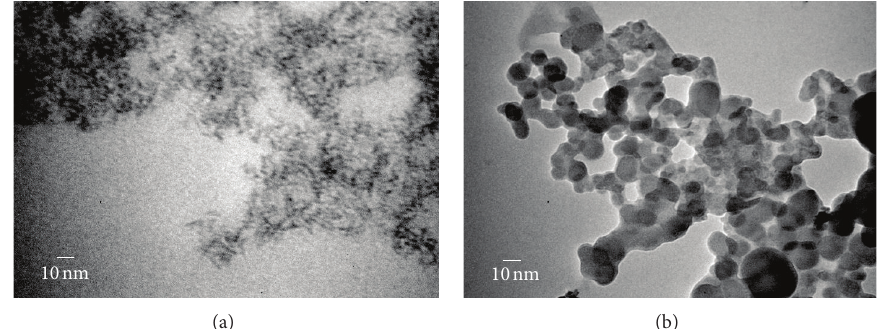
Figure 3: (a) Magnetite nanoparticles and (b) Fe 3 O 4 /PANI nanocomposites.